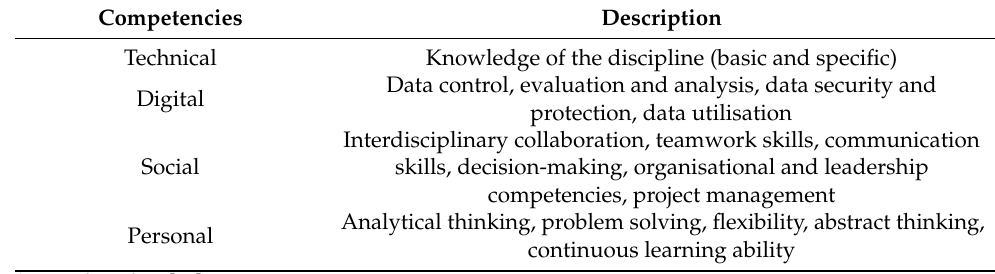
Table 1. Competencies